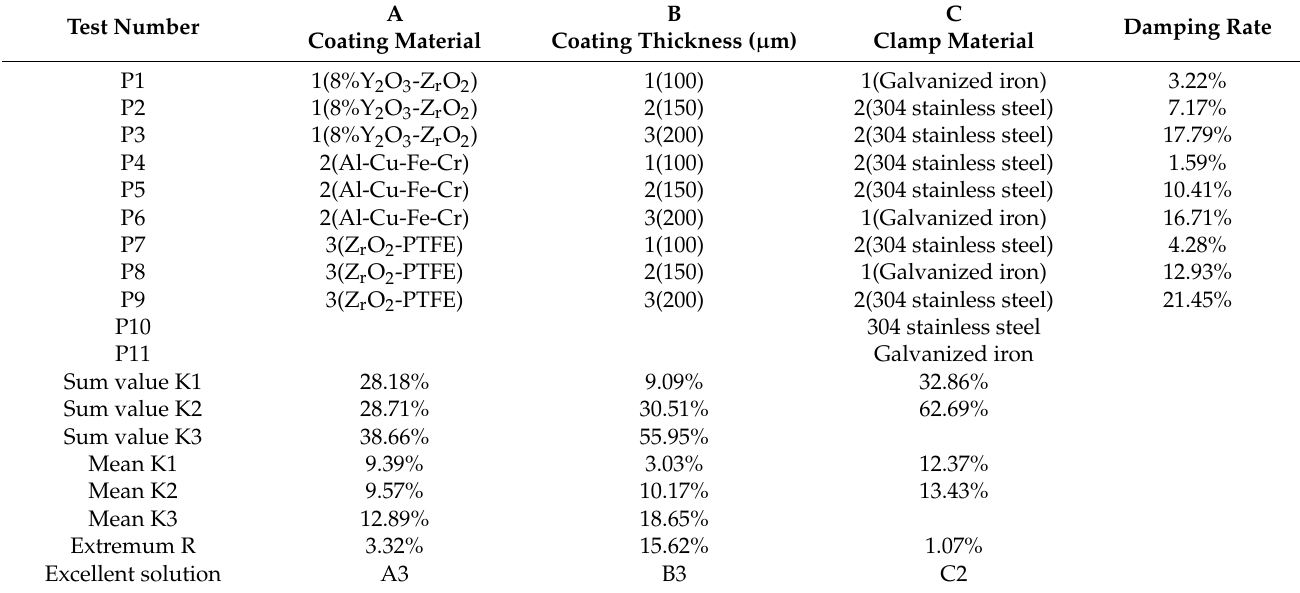
Table 10. Orthogonal test results of vibration response under low-voltage 150 Hz fixed-frequency